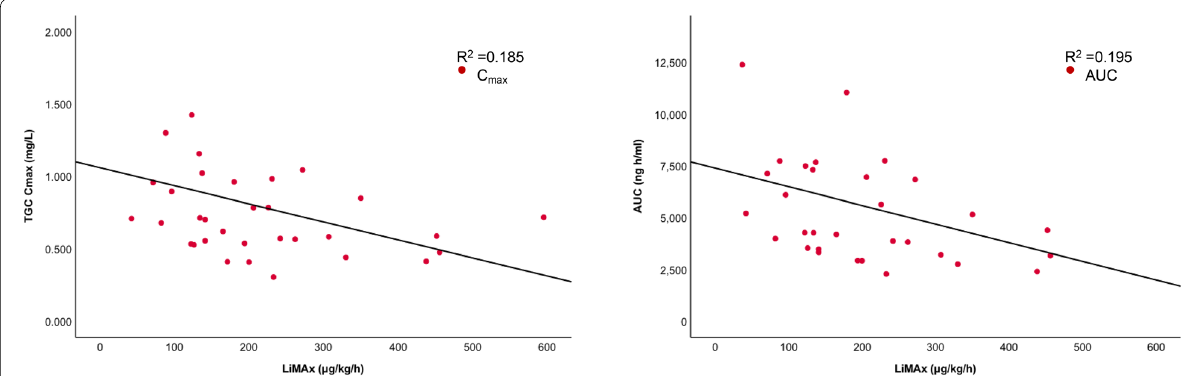
Fig. 3 Relationship between LiMAx and TGC PK, AUC ( a ) and C max ( b ). C max : TGC maximum plasma concentration; AUC: area under the